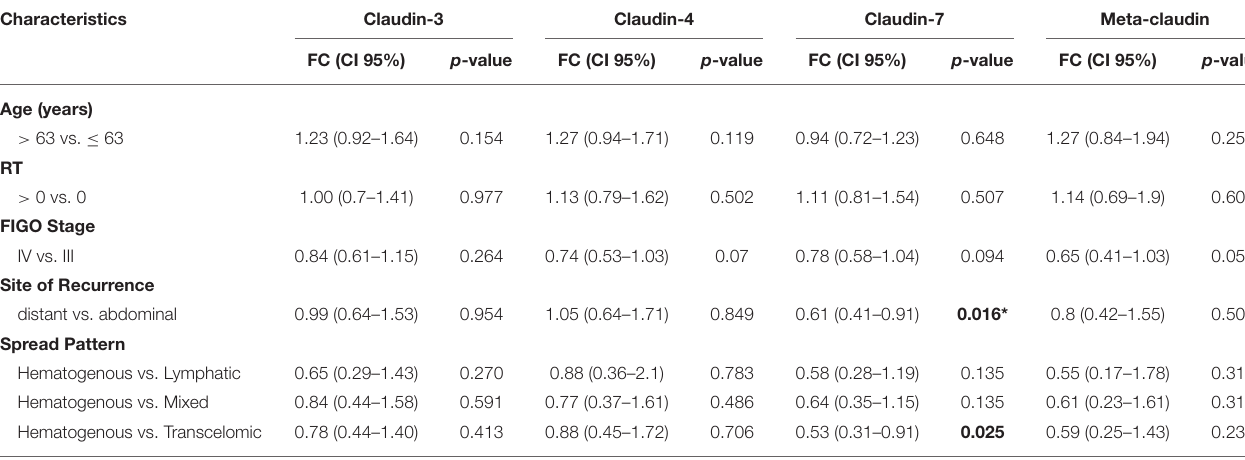
* Corrected for FIGO stage. The association of claudins expression with clinicopathological parameters was tested using linear models. P < 0.05 were considered to be significant and are indicated by bold font.